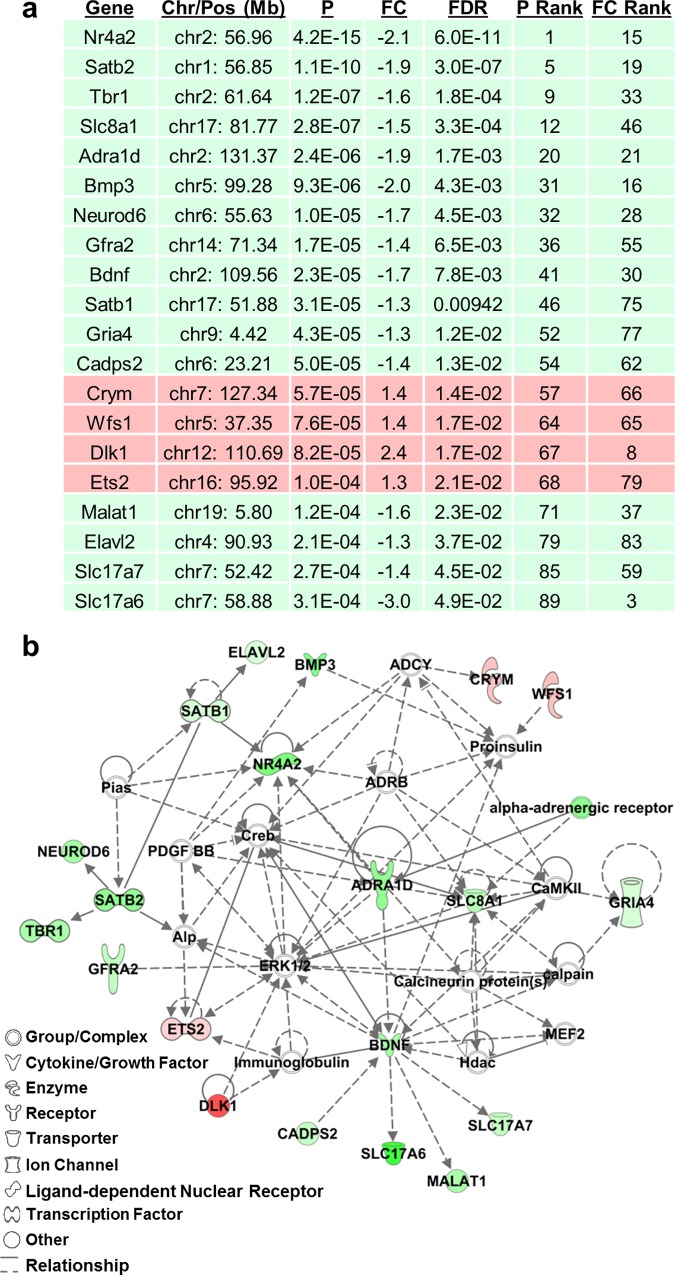
Transcriptome analysis of Line 4a identifies “Cellular Development, Nervous System Development and Function, Behavior” as the top IPA network.
(a, b): 17 downregulated genes (green) and four upregulated genes (red) were identified in the IPA network (S10 Table). Genes in the network diagram that lack any color were included by the IPA algorithm to facilitate connectivity. Chromosome and position (Chr/Pos; mm9) of each gene is shown. P = p-value of differential expression in Line 4a; FC = fold-change in expression; FDR = false discovery rate (< 0.05; 5%), P Rank = rank in p-value (#1 = lowest p-value out of 91 genes); FC Rank = rank in fold-change (#1 = largest fold-change out of 91 genes).